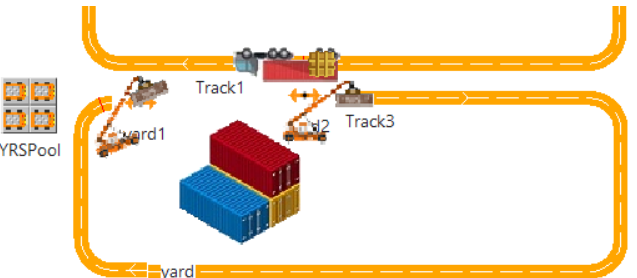
Figure 7. Yard operation.